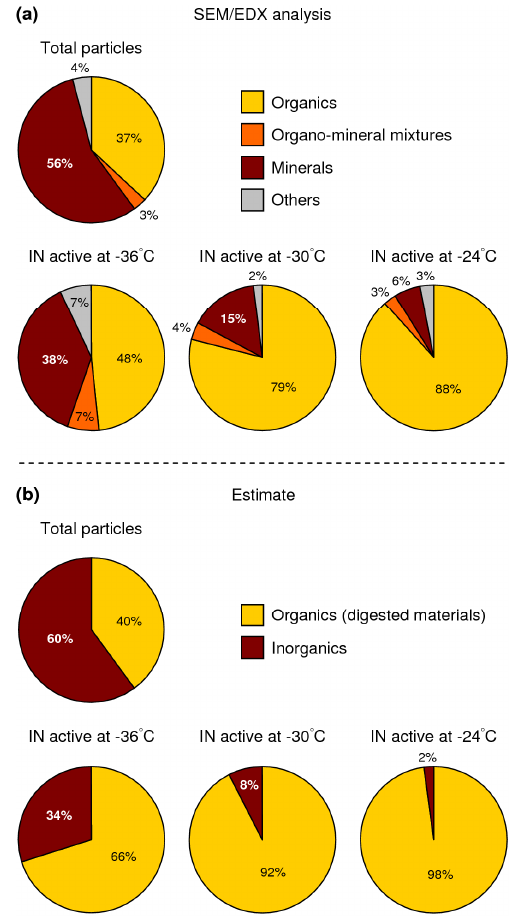
Figure 5. Relative contributions of different particle types to agri- cultural soil dusts. (a) Compositions of the total dust aerosol parti- cles ( n = 95) and IN active at − 36, − 30 and − 24 ◦ C ( n = 58, 52 Fig. 5. Relative contributions of different particle types to agricultural soil dusts. (a) 3 and 68) determined by SEM/EDX analysis. Untreated sugar beat soil dust particles are used. (b) Compositions of the IN active at Compositions of the total dust aerosol particles ( n = 95) and IN active at –36°C, –30°C and –4 − 36, − 30 and − 24 ◦ C estimated from the freezing experiments 24°C ( n = 58, 52 and 68) determined by SEM/EDX analysis. Untreated sugar beat soil dust 5 with untreated and H 2 O 2 -treated agricultural soil dusts. In this cal- culation, the percentages of organic and inorganic particles in the particles are used. (b) Compositions of the IN active at –36°C, –30°C and –24°C estimated 6 total dust aerosol particles are set to 40 and 60%, respectively, and then the n s parameterizations presented in Fig. A1a are used to es- from the freezing experiments with untreated and H timate the number fractions of organic and inorganic calculation, the percentages of organic and inorganic particles in the total dust aerosol 8 particles are set to 40% and 60%, respectively, and then the n Fig. A1a are used to estimate the number fractions of organic and inorganic IN. 10